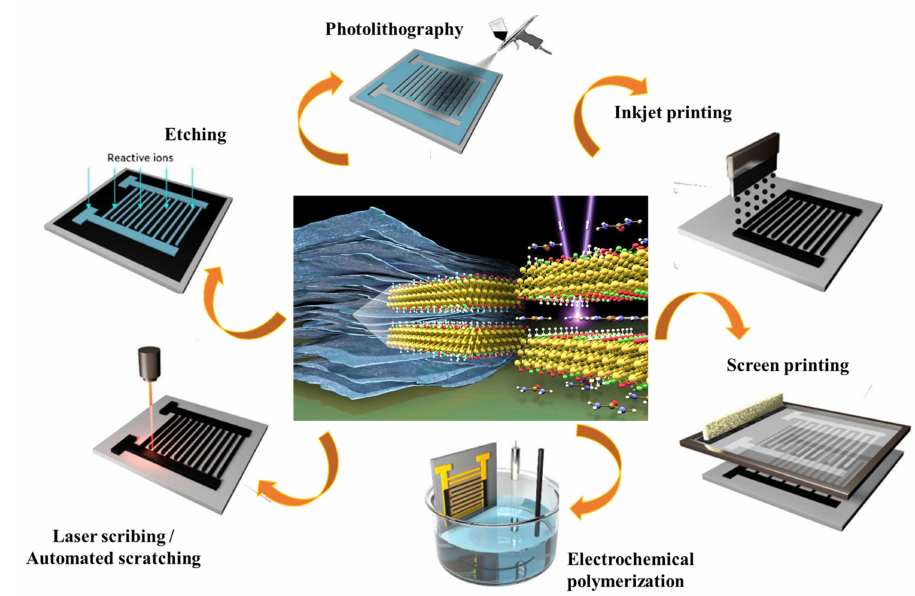
Figure 9. The fabrication methods for interdigital MXene